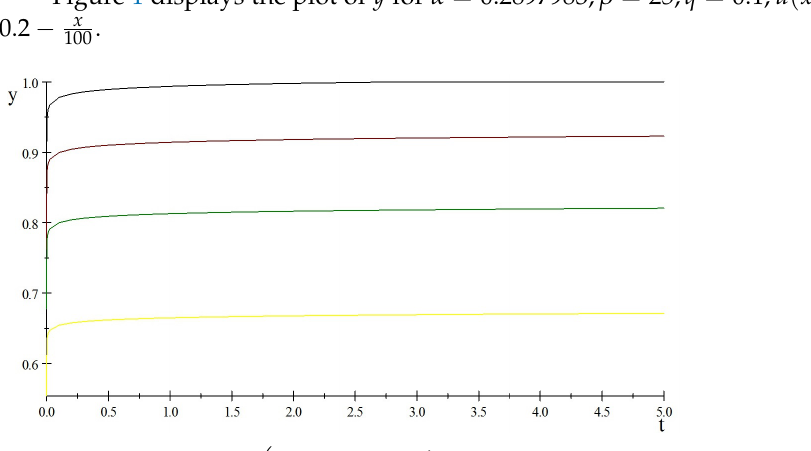
(cid:16) (cid:98) α = 0.2897983, (cid:98) β = 25, q = 0.1, u ( x ) = − 4, b ( x ) = 0.2 −